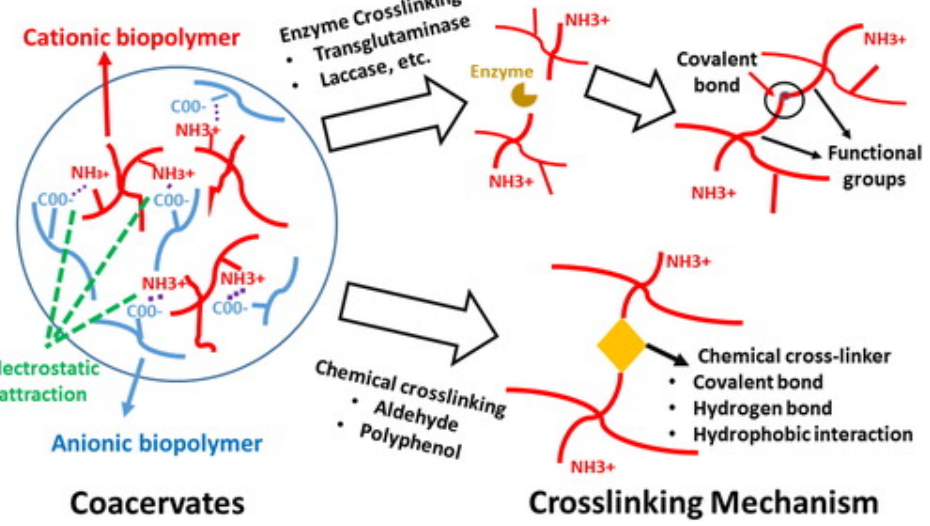
Figure 6. Mechanistic view of the crosslinking/hardening of coacervates encapsulating essential oils (reproduced with permission) [188].